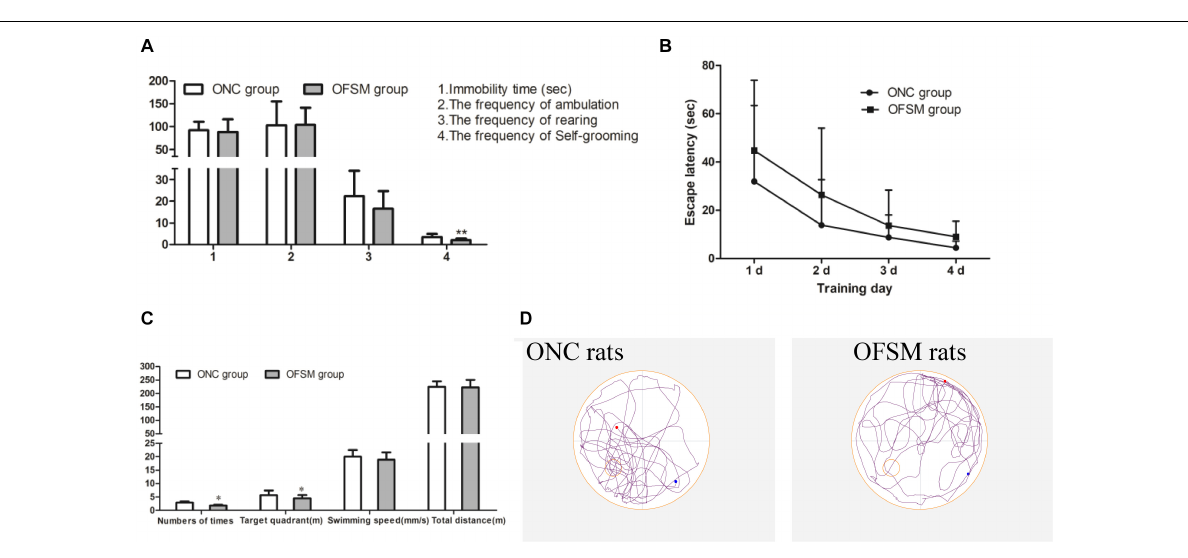
Figure 4C ) between the two groups. The swimming